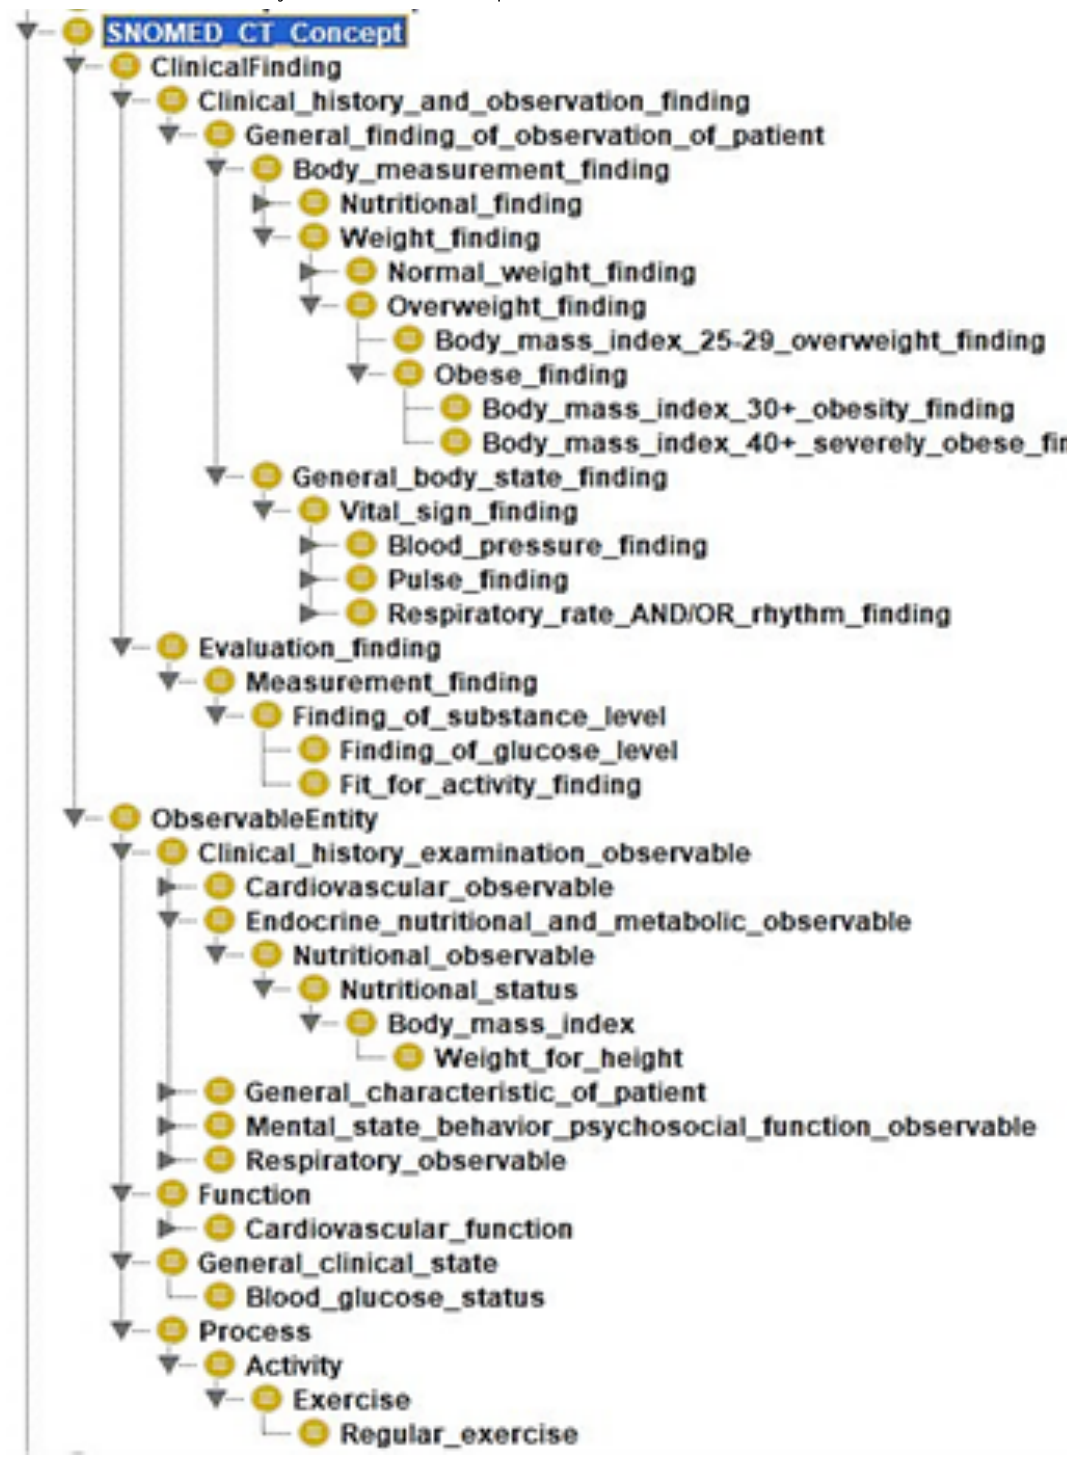
Figure 7. SNOMED CT class hierarchy based on selected